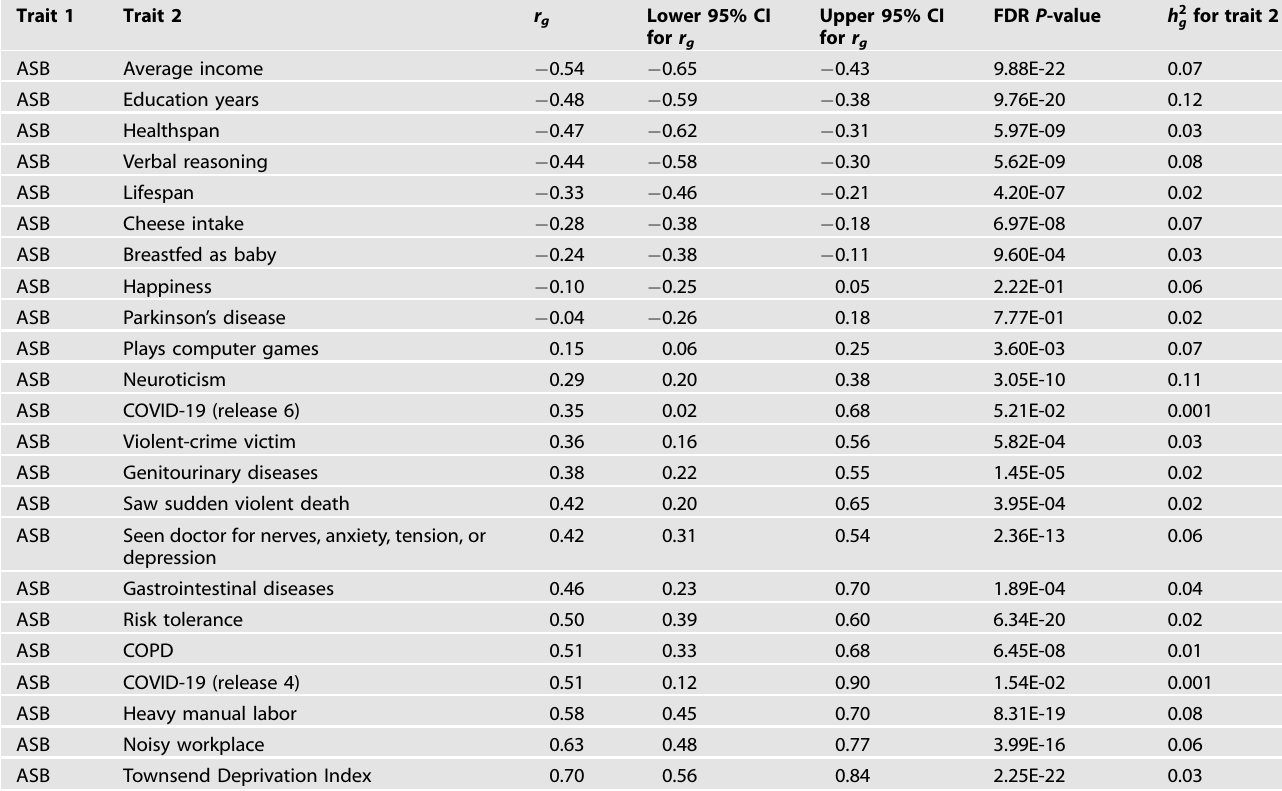
Table 2. Genetic correlations ( r gs ) for ASB and health and behavioral